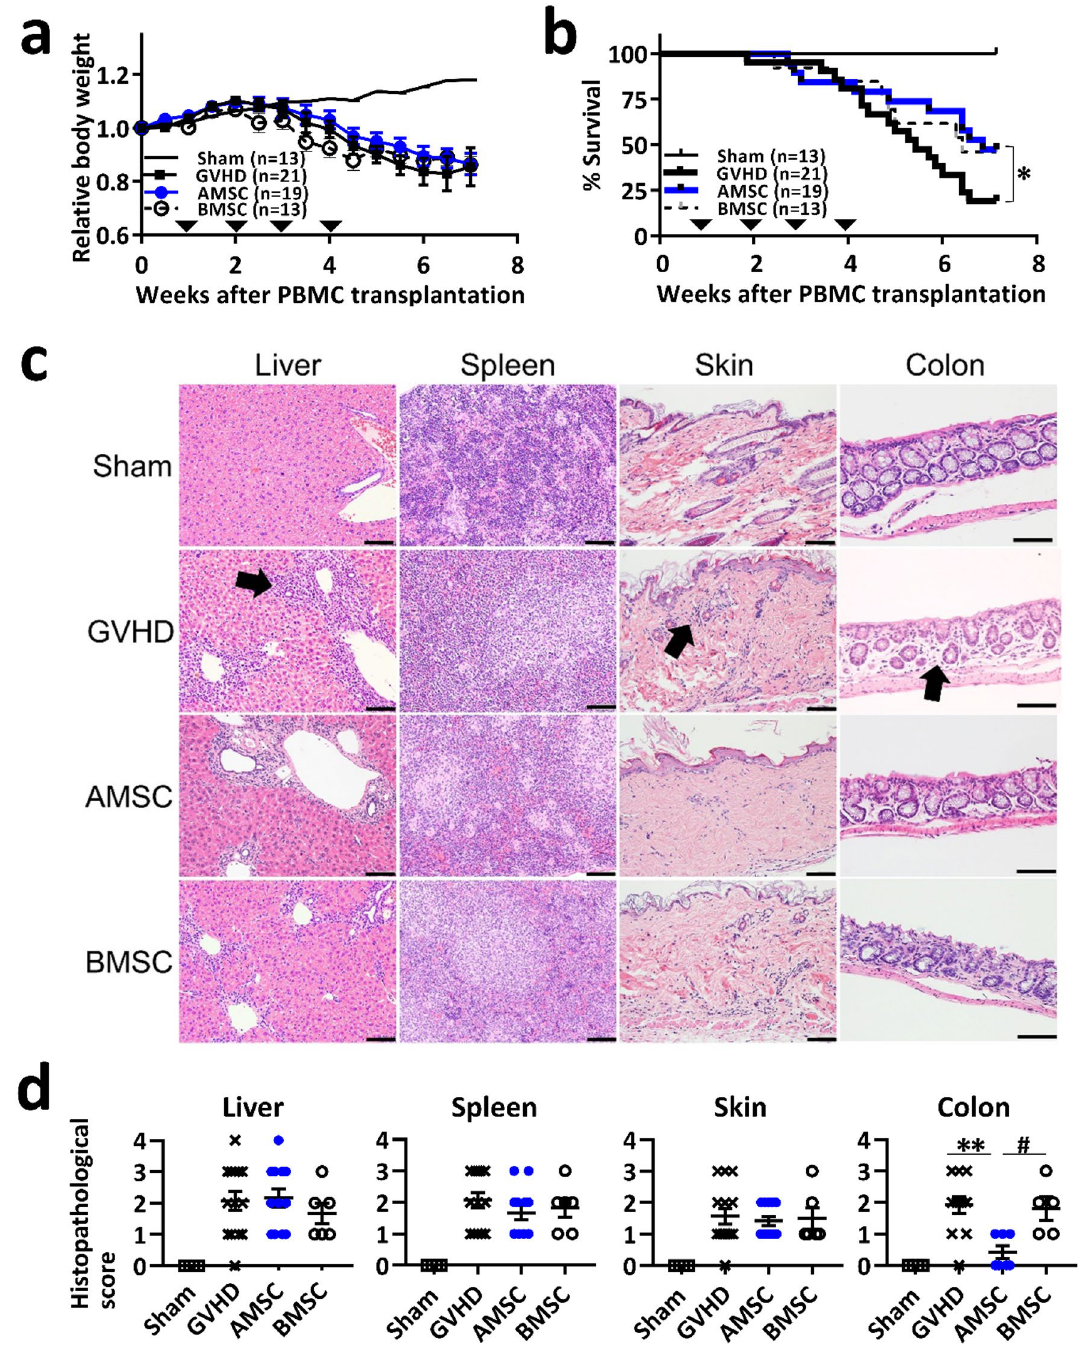
Figure 1. AMSC have immunosuppressive effects in xeno-GVHD mice. GVHD was induced by transplantation of 3 × 10 6 cells/mouse PBMC administered intravenously on week 0. Mice were subsequently administered 8 × 10 6 cells/kg AMSC (n = 19) or BMSC (n = 13) intravenously once a week from week 1 to 4 (inverted triangle). Sham (n = 13) and GVHD control (n = 21) mice were administered vehicle. In this long- term experiment, survived mice in all groups were sacrificed at week 7. Combined data from two or three independent experiments are represented. ( a , b ) Relative body weight and survival rate. ( c ) H&E staining of liver, spleen, skin, and colon tissues. Mononuclear cell infiltration ( ↑ ) are represented in GVHD target organs. Magnification, × 200. Scale bar, 50 μm. ( d ) Histopathological scores of liver, spleen, skin, and colon tissues. Data are represented as mean ± SEM. Each symbol represents an individual mouse. # P < 0.05 AMSC versus BMSC; * P < 0.05, ** P < 0.01 AMSC versus